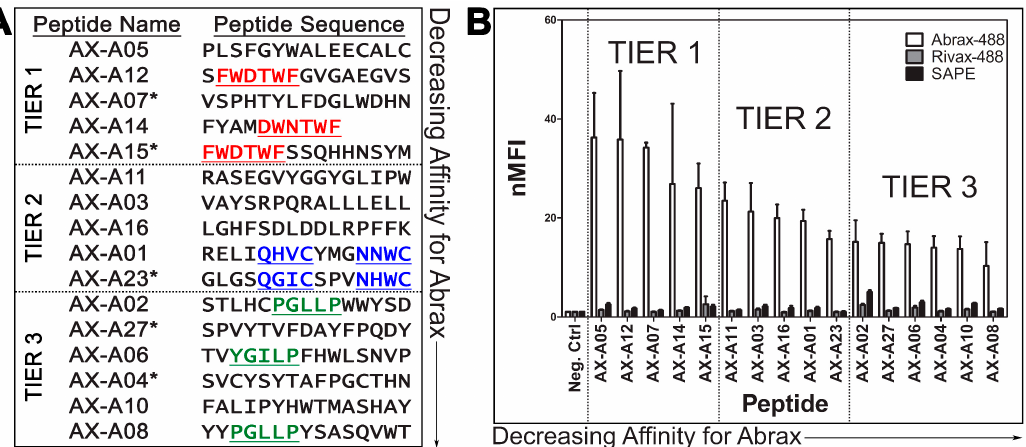
Figure 1. Three Consensus Families of Peptides Observed with Varying Binding Affinity: ( A ) Abrax binding peptide sequences with consensus families underlined and repeating sequences starred (*); and ( B ) FACS analysis of peptide binding to abrax-488 (white bars), RiVax-488 (gray bars), and Streptavidin-R-Phycoerythrin (SAPE, black bars). Plotted data are the average (bars) and standard deviation (error bars) of the normalized Median Fluorescence Intensity (nMFI) for three independent replicate experiments, normalized to the negative control cells. Actual values used for these calculations are shown in Tables S1–S3. The candidates are separated into three tiers based on abrax binding affinity and the focus of the remainder this work will include Tier 1 (highest affinity) peptides only.